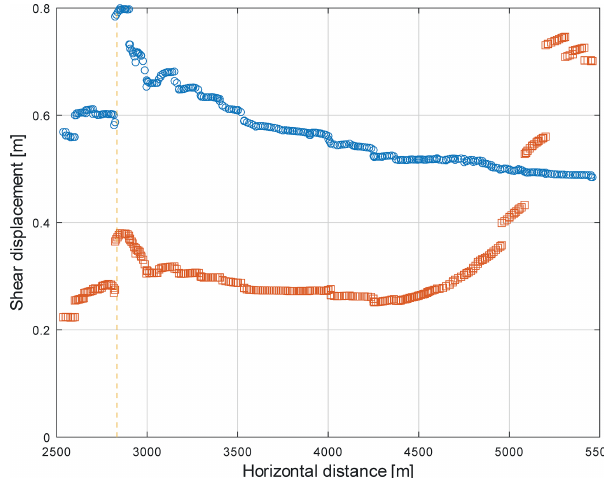
Figure 12. Spatial distribution of shear displacement along the basal shear zone for the model types with horizontal and vertical joint sets (blue circles; see Fig. 10e) and inclined (32 ◦ ) and vertical joint sets (red squares; see Fig. 10f). At model location x = 2823m, a step in shear displacement occurred due to a kink in the basal shear zone. Both model types are based on groundwater flow (see Fig. 9b,